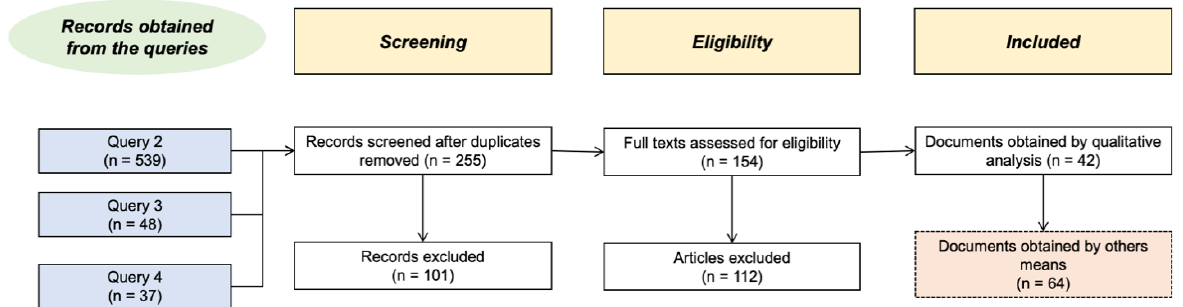
Figure 1. Systematic query results—adapted from preferred reporting items for systematic reviews and meta-analyses (PRISMA) flow diagram [69,70].